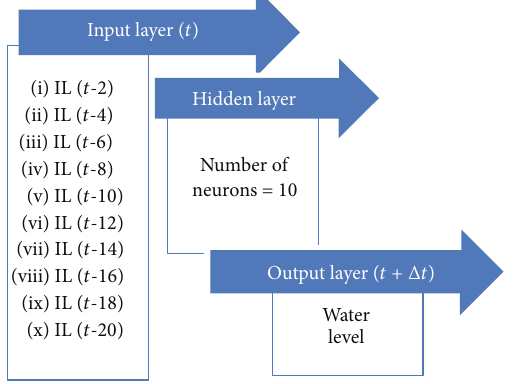
Figure 10: Schematized ANN prediction model.